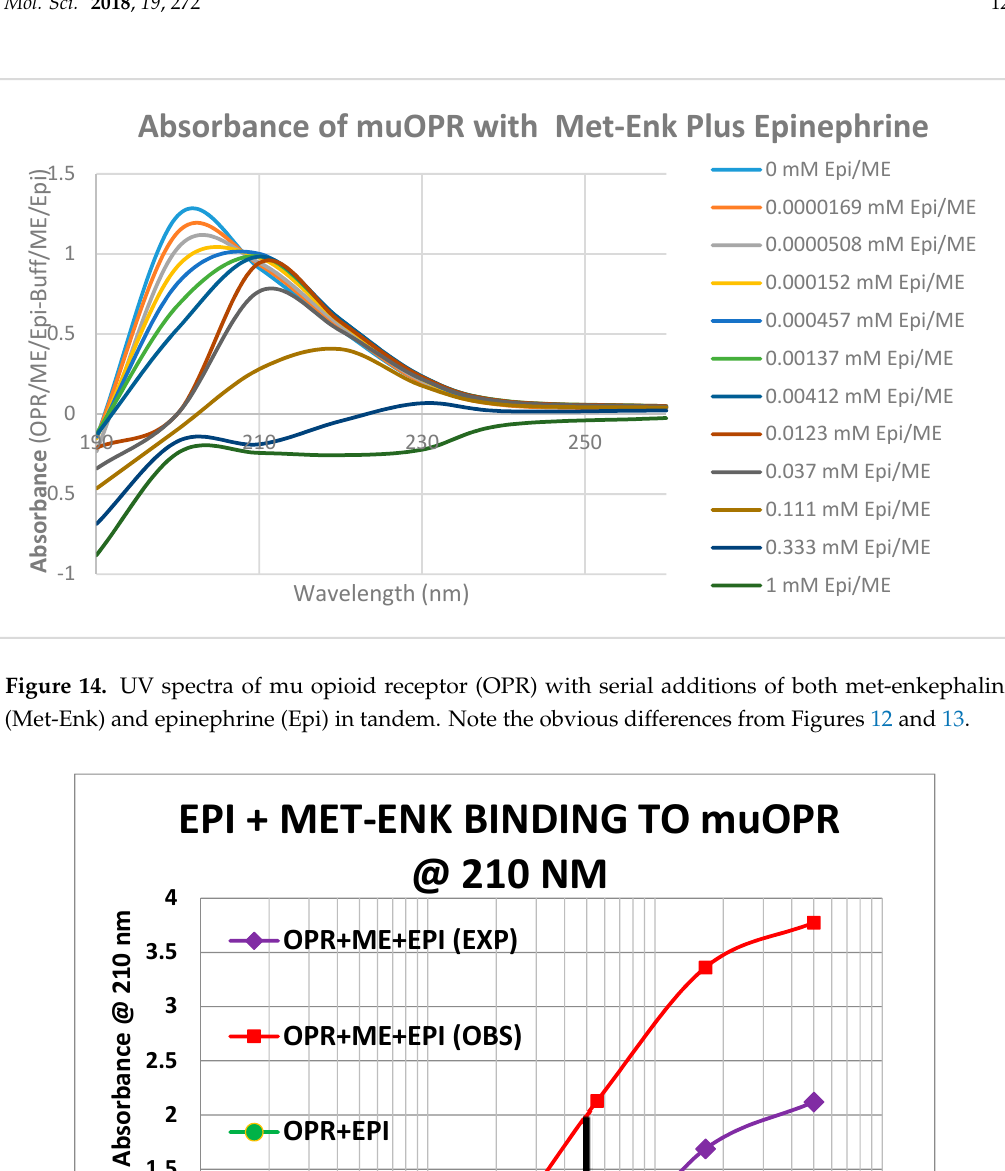
Figure 13. UV spectra of mu opioid receptor (OPR) with serial additions of epinephrine HCl (Epi). Note the very significant differences between these spectra and those in Figures 10 and 11.